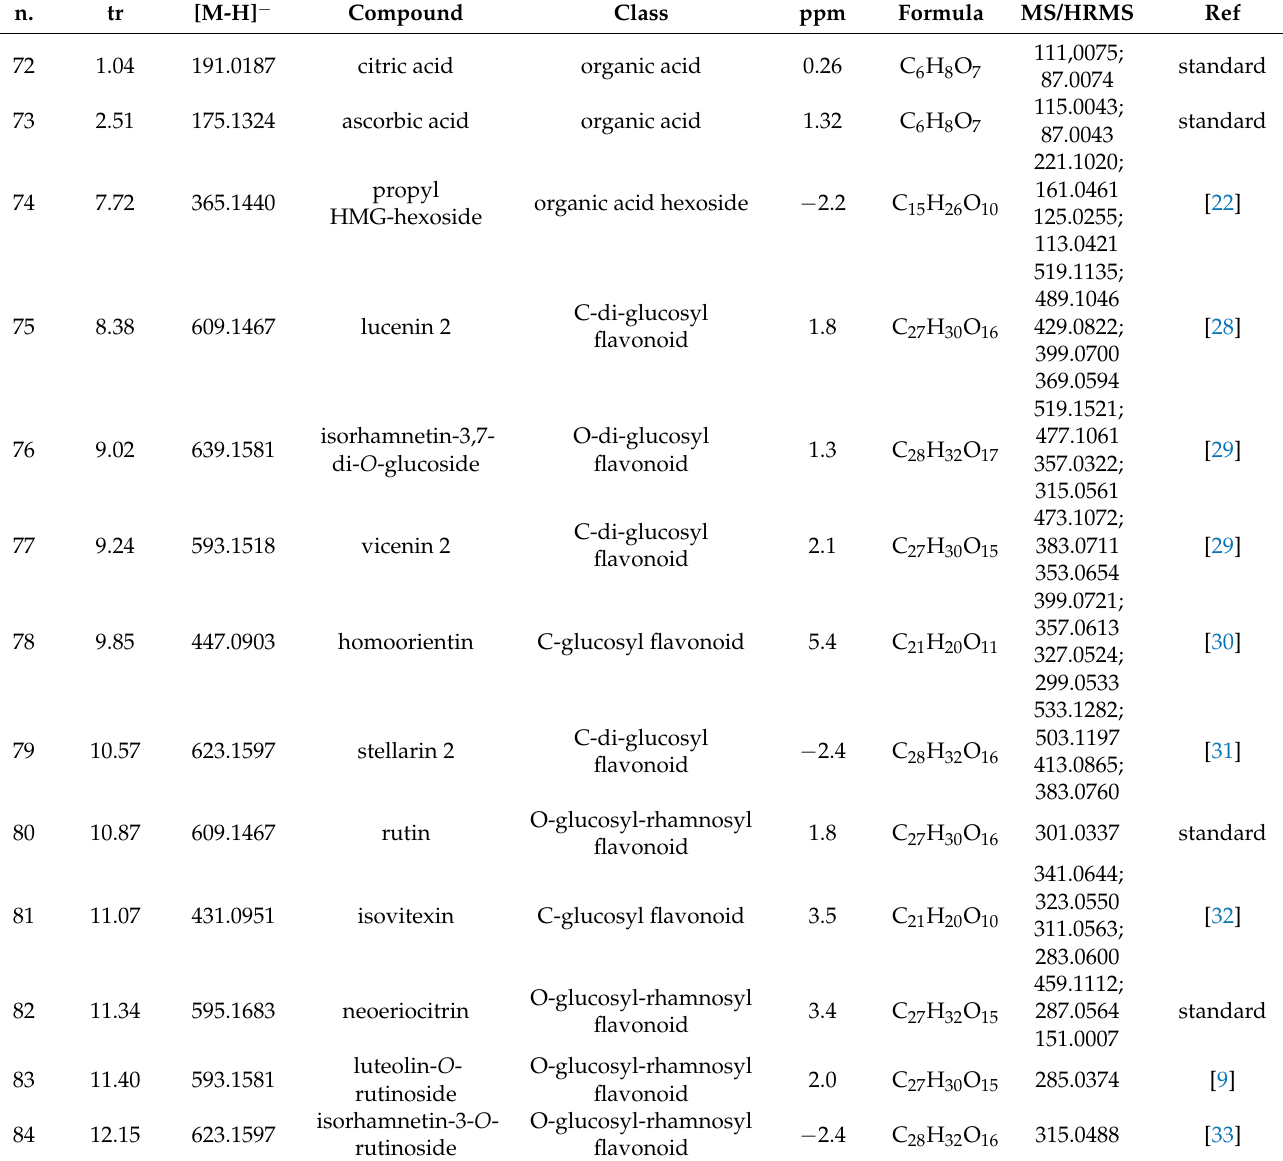
Table 3. LC-MS data for organic acids, phenolic compounds, and limonoids detected in chloroform peel, pulp, albedo, and seed extracts of Faustrime